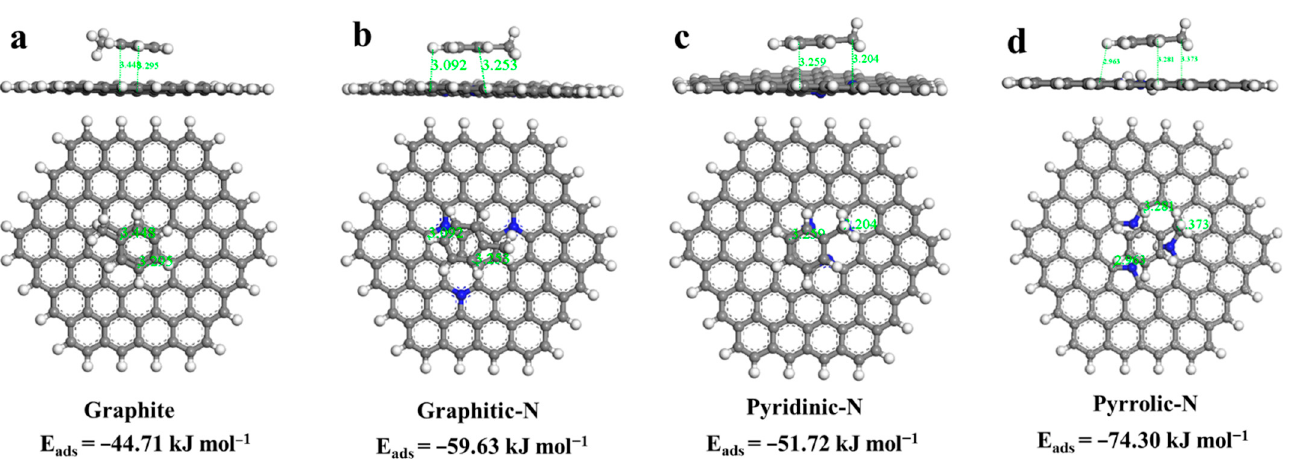
Figure 6. Optimized geometry and stable adsorption configurations of toluene on various nitrogen- containing functional groups, including pure graphite ( a ), graphitic-N ( b ), pyridinic-N ( c ), and pyrrolic-N ( d ).